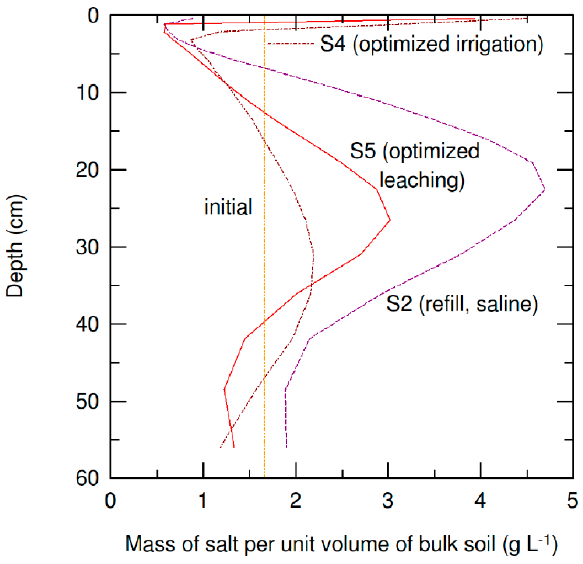
Figure 6. Salt content over the soil profile at the end of the growing season for scenario 2, 4, and 5.